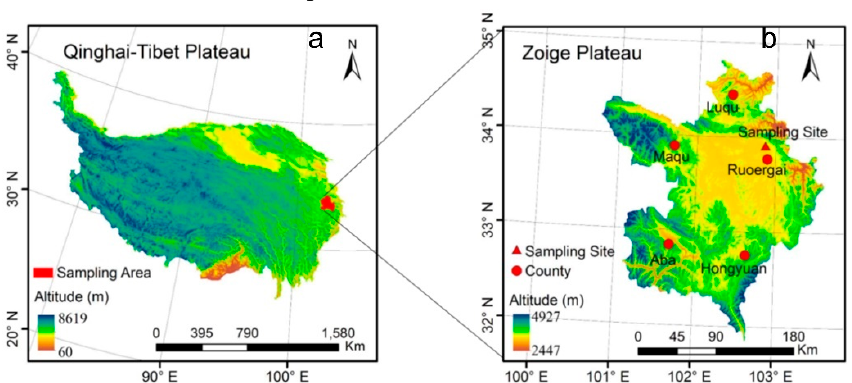
Figure 1. Maps of the study area showing the five main counties (red circles) and the sampling site (red triangle) on the Zoige Plateau ( b ) on the Qinghai–Tibet Plateau ( a ). Different colors represent different altitudes.